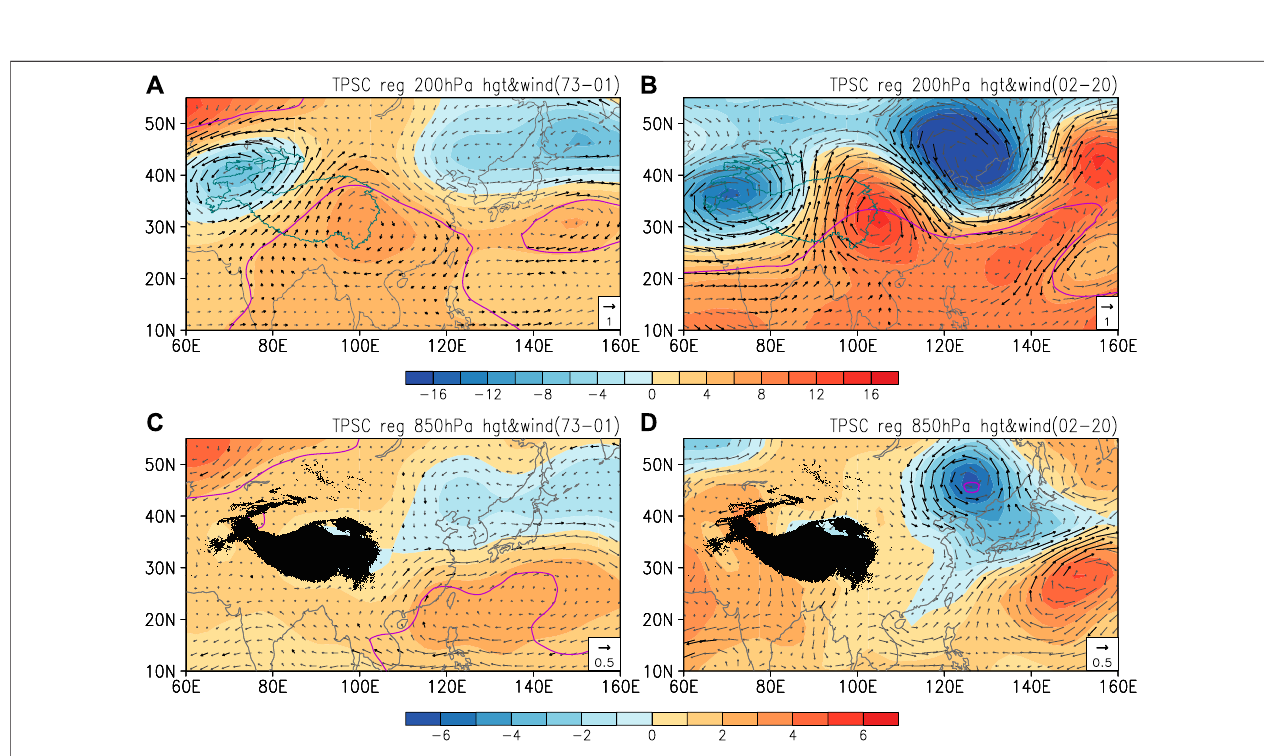
FIGURE3| Anomaliesof (A,B) 200 hPaand (C,D) 850 hPageopotentialheight(hgt)(shading,gpm)andwind(vector,m/s)insummerobtainedbylinearregressionagainst thewestern Tibetan Plateau summer snowcover indexfor theperiod (A,C) 1973 — 2001and (B, D) 2002 — 2020.Thescalefor windsis shown at thebottom-rightcorner. The black vectors denote wind anomalies signi fi cant at the 95% con fi dence level. The purple contours denote geopotential height anomalies signi fi cant at the 95% con fi dence level.